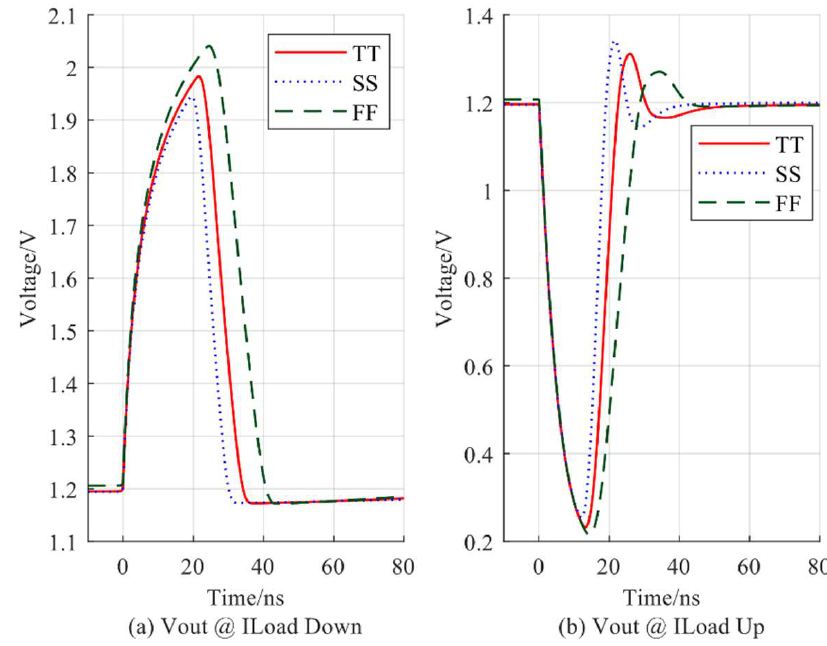
Figure 10. Transient Response.